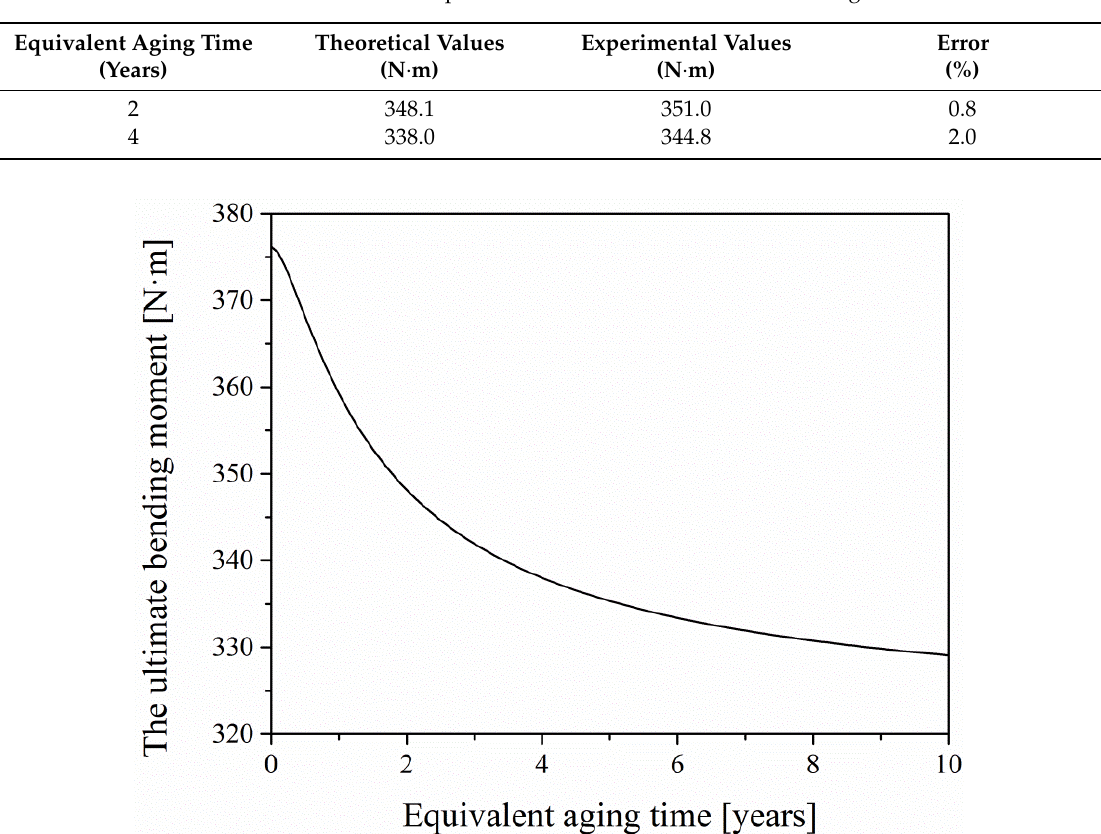
Figure 14. The ultimate bending moment–equivalent aging time curve.